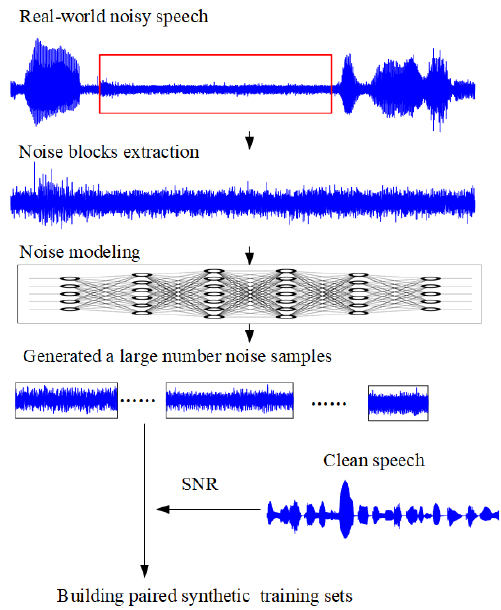
Figure 4. Training set construction process.